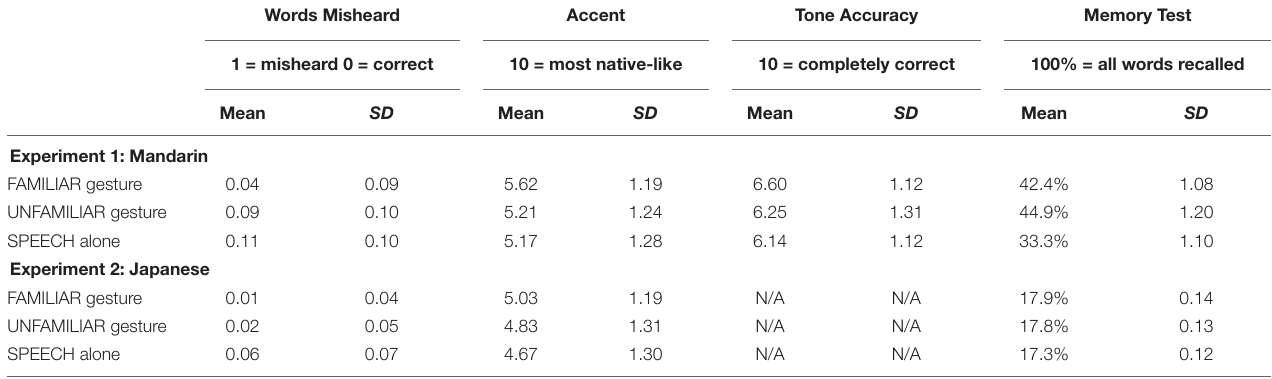
TABLE 1 | Means and standard deviations of native speaker responses in the L2 “Speech” evaluation.